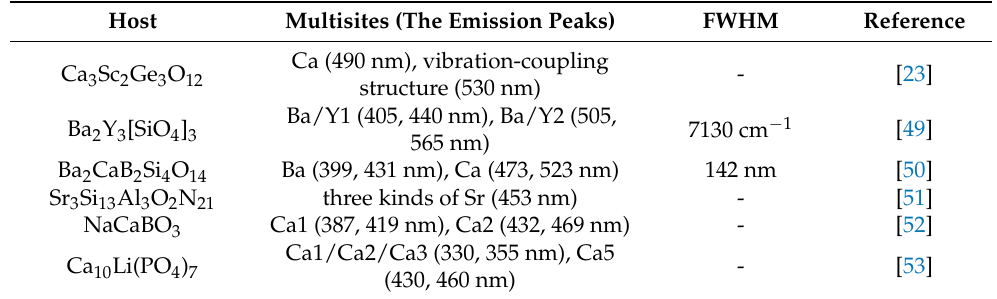
Figure 5. ( a ) Crystal structure of Y 3 Si 5 N 9 O and coordination polyhedral of Y1 and Y2. ( b ) PL emission spectrum of Y 2.9 Si 5 N 9 O:Ce 0.1 under the excitation of 435 nm radiation. Reprinted with permission from ref. [47]. Copyright 2016 American Chemical Society. ( c ) Approximate crystal structure of La 5 Si 2 BO 13 . ( d ) The detailed Gaussian fitting results of La 5 Si 2 BO 13 :0.05Ce 3+ , 0.05Eu 2+ sample. Reprinted with permission from ref. [48]. Copyright 2021 Elsevier B.V. Table 2. Summary of structural and luminescent information for some Ce 3+ -doped multi-site